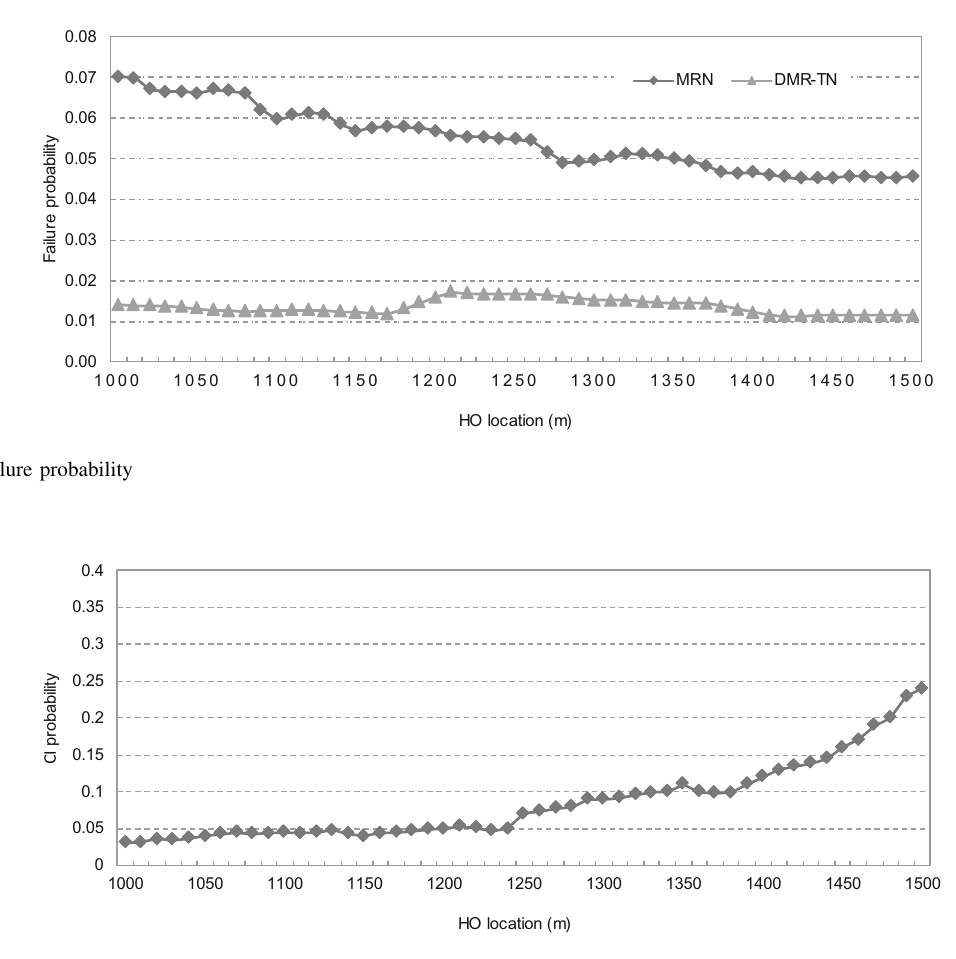
Fig. 9 Communication interruption probability for the proposed DMR-TN